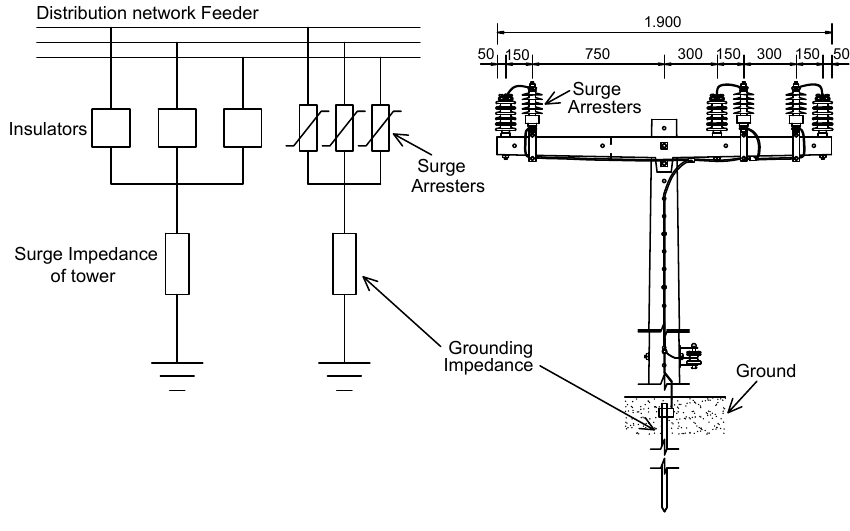
Figure 3. Elements of the type P2 pole.